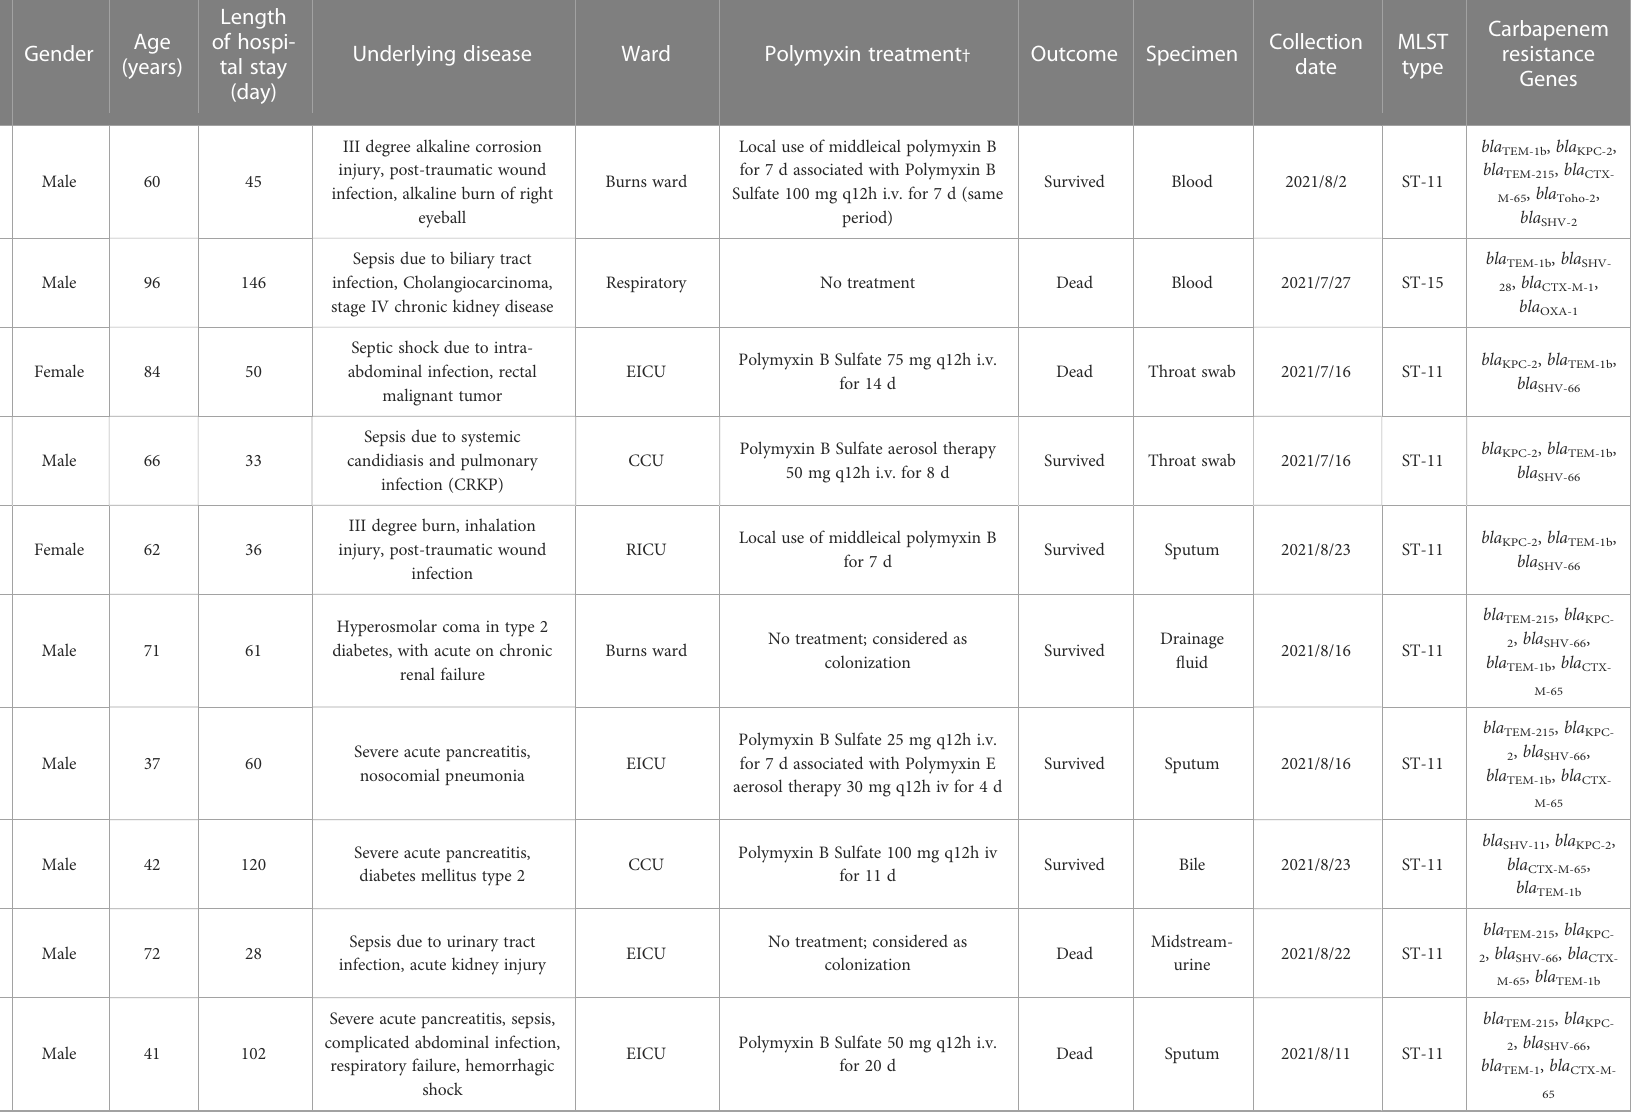
TABLE 1 Patient demographics and main characteristics of polymyxin-resistant K. pneumoniae and E. coli .